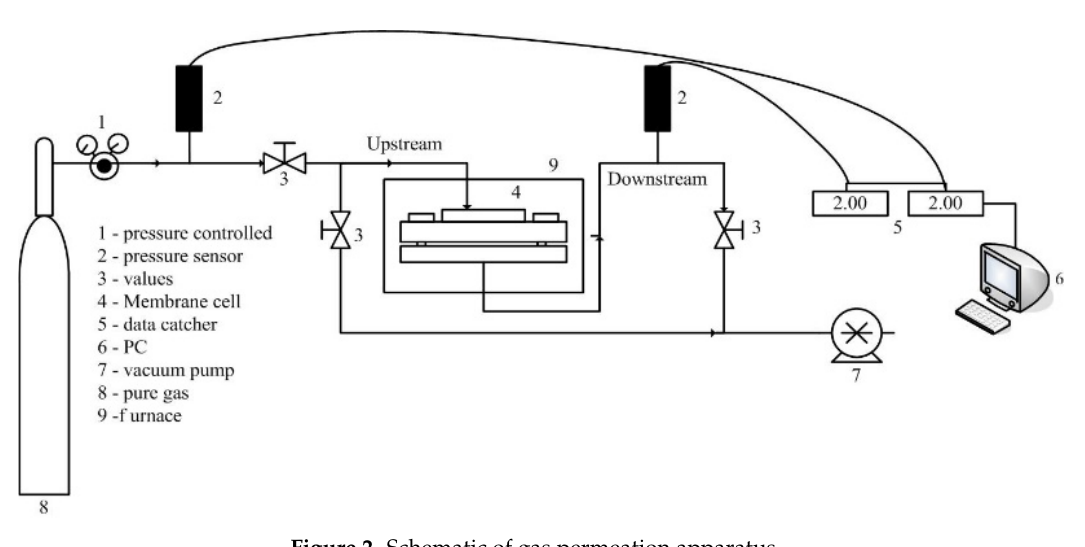
Figure 2. Schematic of gas permeation apparatus.